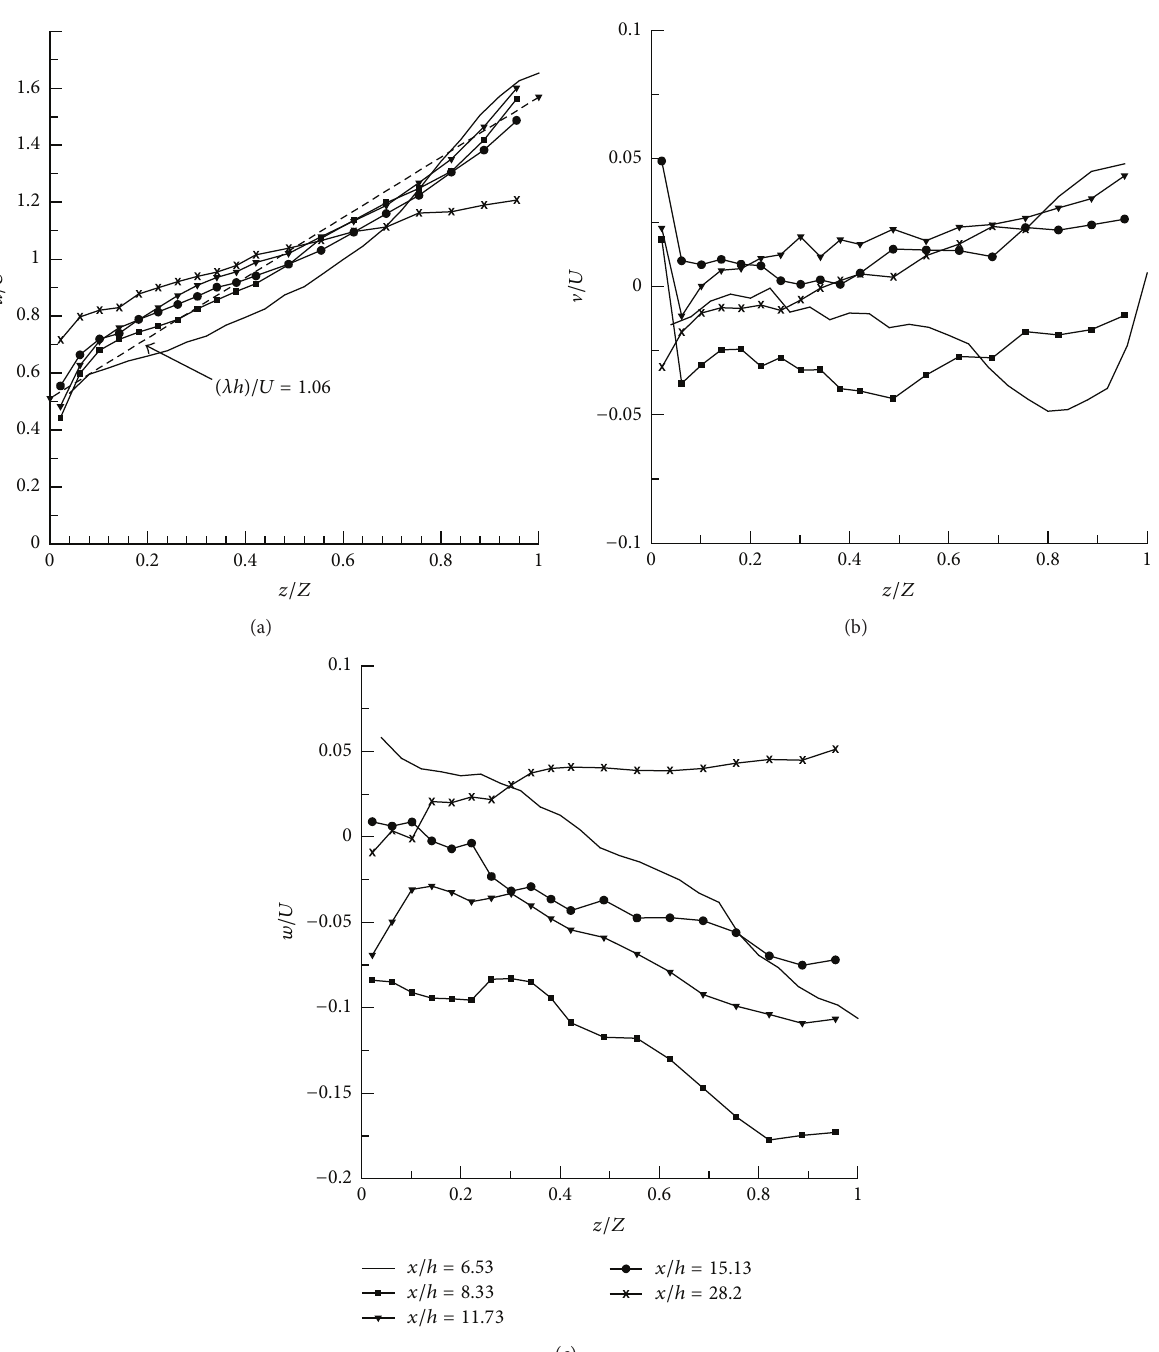
Figure 5: Velocity profile decay of shear flow, generated by